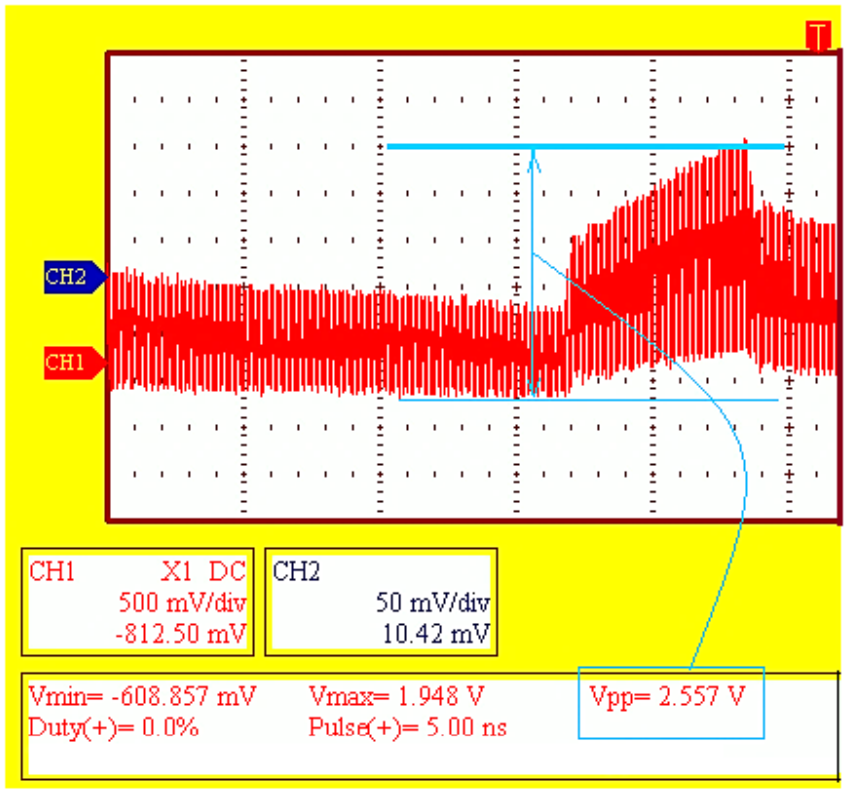
Figure 14. Converter output voltage measurement of peak-to-peak ripple and the capsule’s temperature detected for the film capacitor.